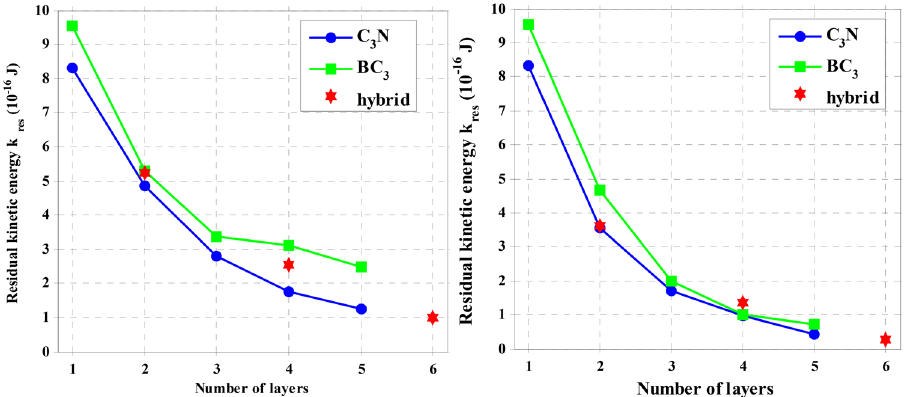
Figure 5. The number of layers’ effect on the residual kinetic energy Kres in the C3N, BC3, and C3N-BC3 hybrid nanosheets with K